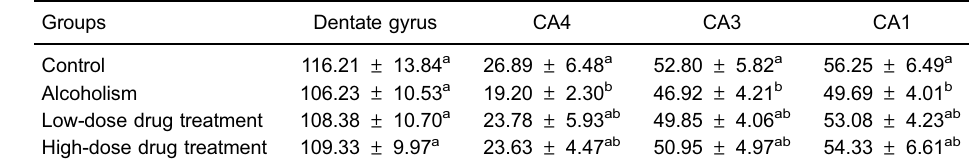
Table 2. Number of tropomyosin receptor kinase B (TrkB)-positive neurons in the dentate gyrus and hippocampus (CA4, CA3, and CA1) in the four groups.